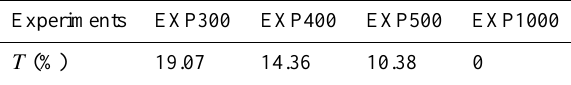
Table 2. Fraction of time with flow reversal in the viscous sub-layer for y ∈ [+ 125 , + 2250km ] ( T ).